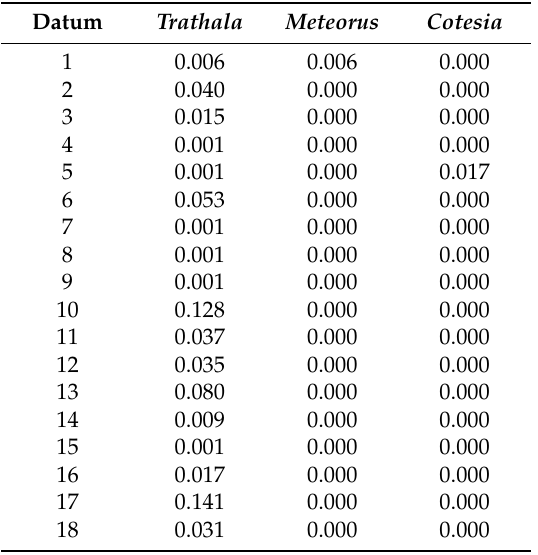
Table 5. Marginal attack rate data used for simulations in Question 3. (Data from